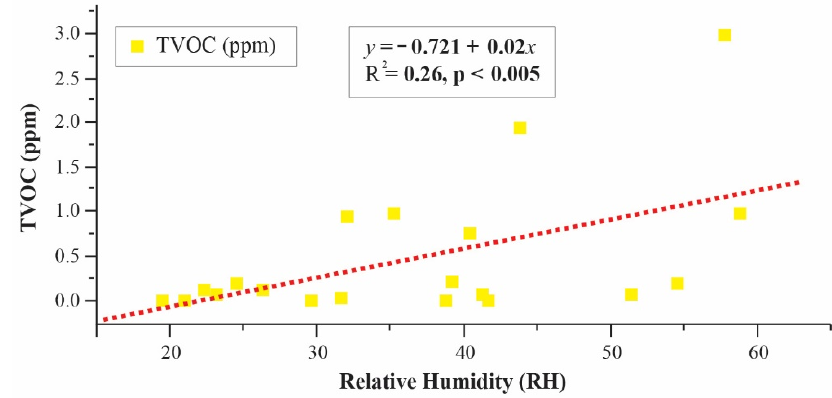
Figure 16. TVOC concentration by relative humidity.